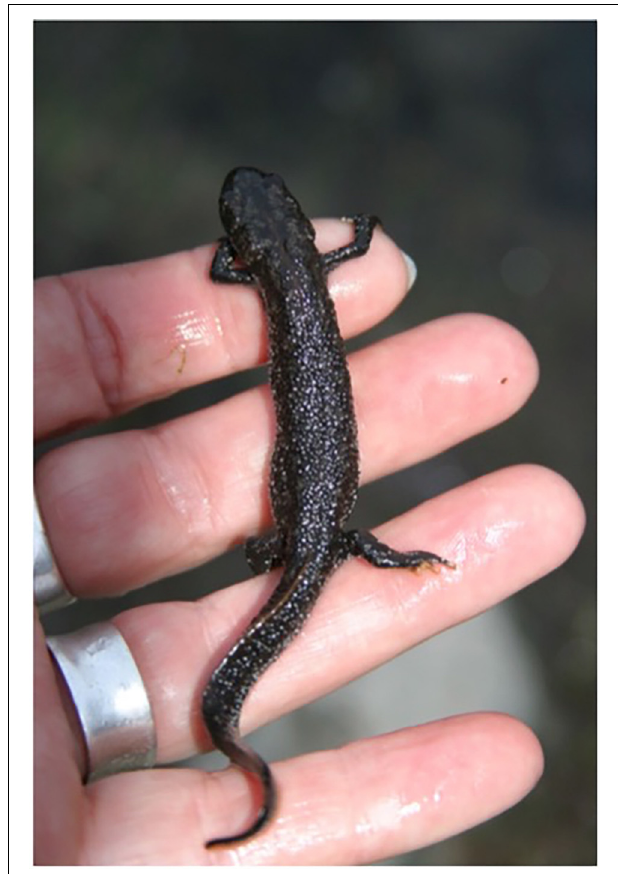
FIGURE 3 | Developing affective relationships with nature by way of significant experiences when saving the life of an animal, here by handling the species: carrying a great crested newt in one’s hand. Photo: Martina